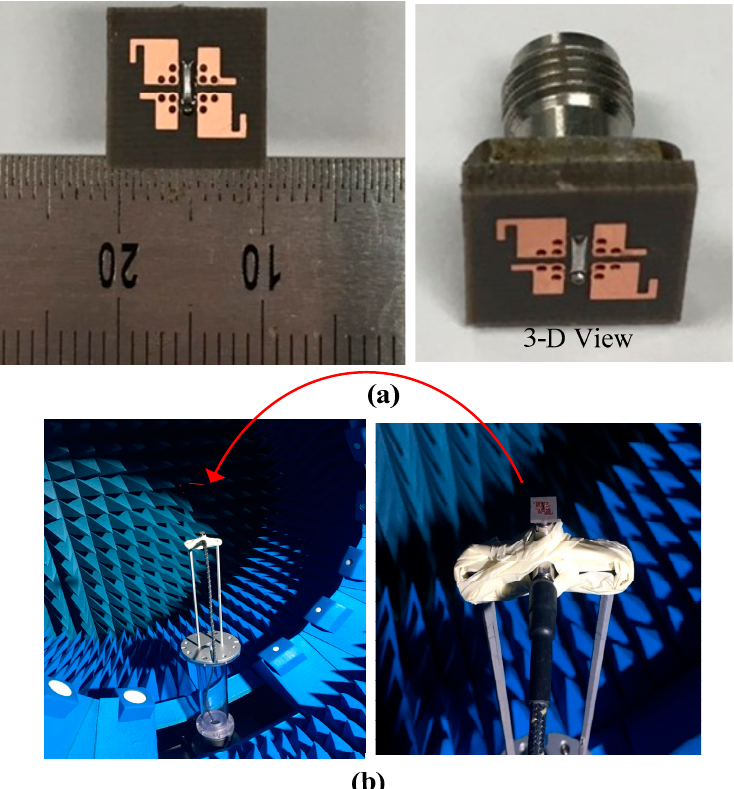
Figure 4. Photographs of the proposed CP ME dipole antenna: ( a ) fabricated prototype and ( b ) far field measurement setup.